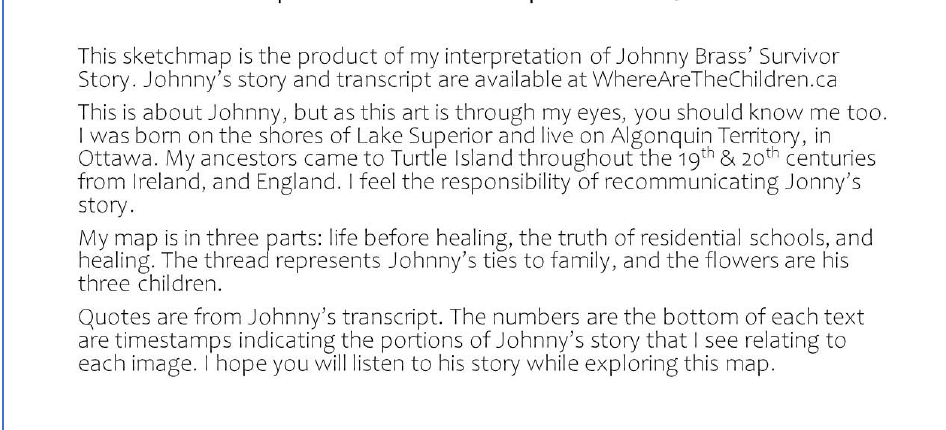
Figure 6. Interpretative map guide to Peter Farrell ’ s sketch mapping of Johnny Brass’s story.